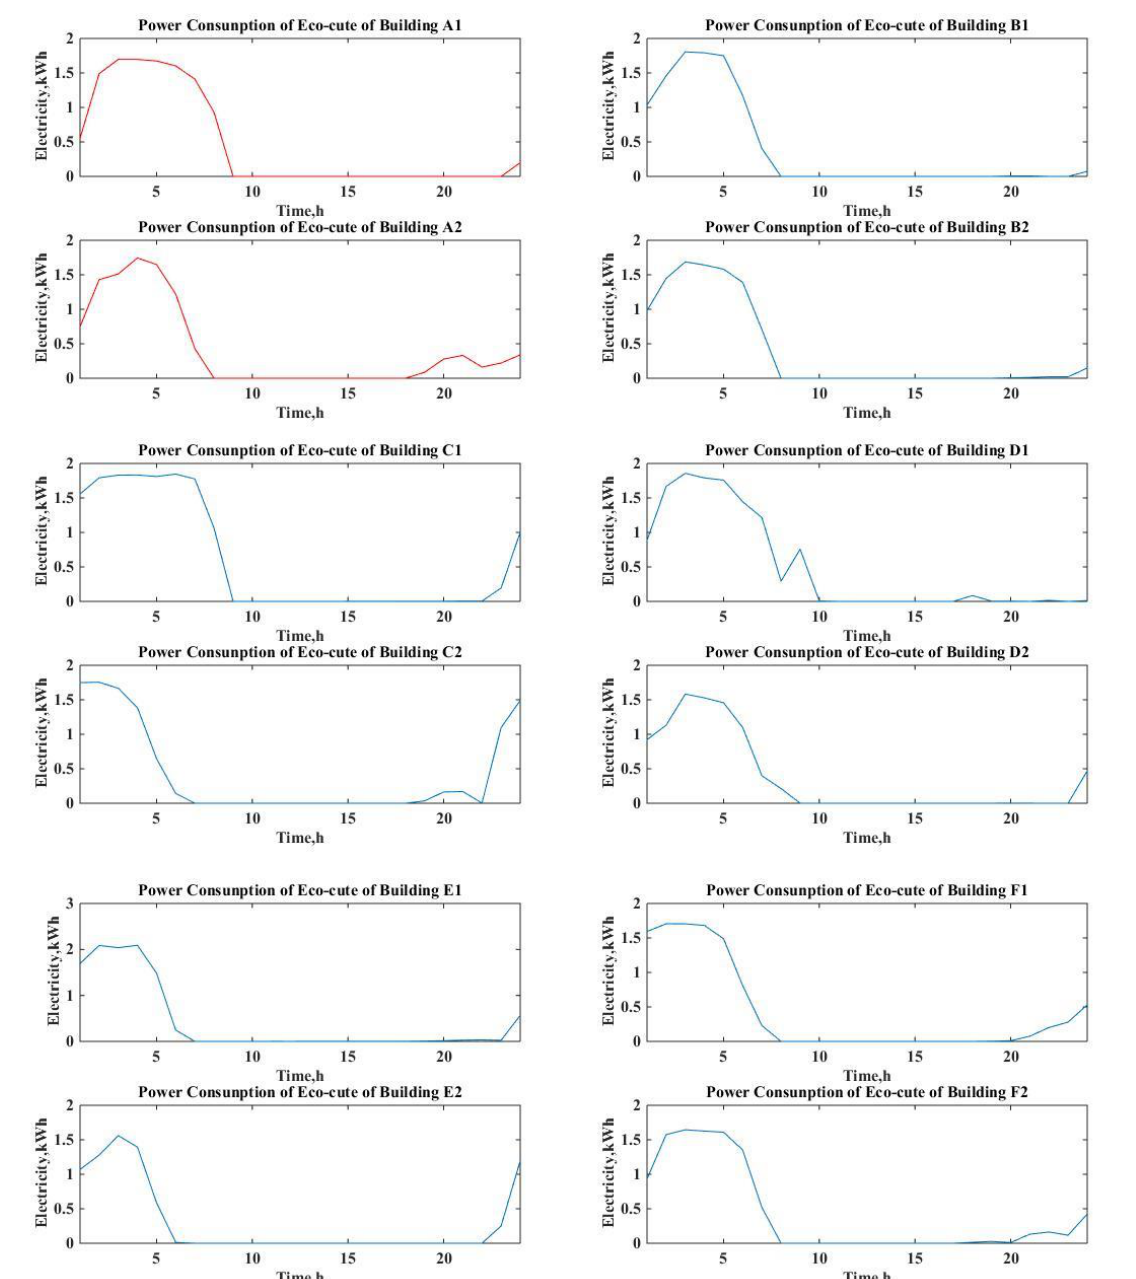
Figure 4. Comparison of power consumption of Eco-cute between the different